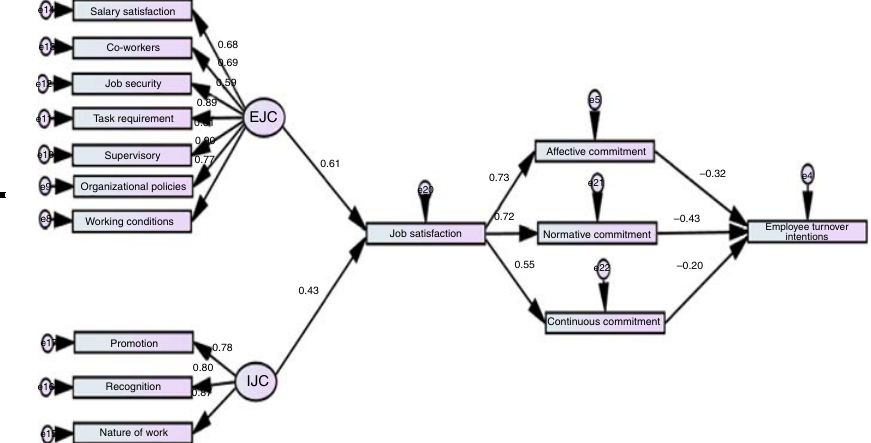
Figure 5. The relationship among job characteristics organizational commitment and employee turnover